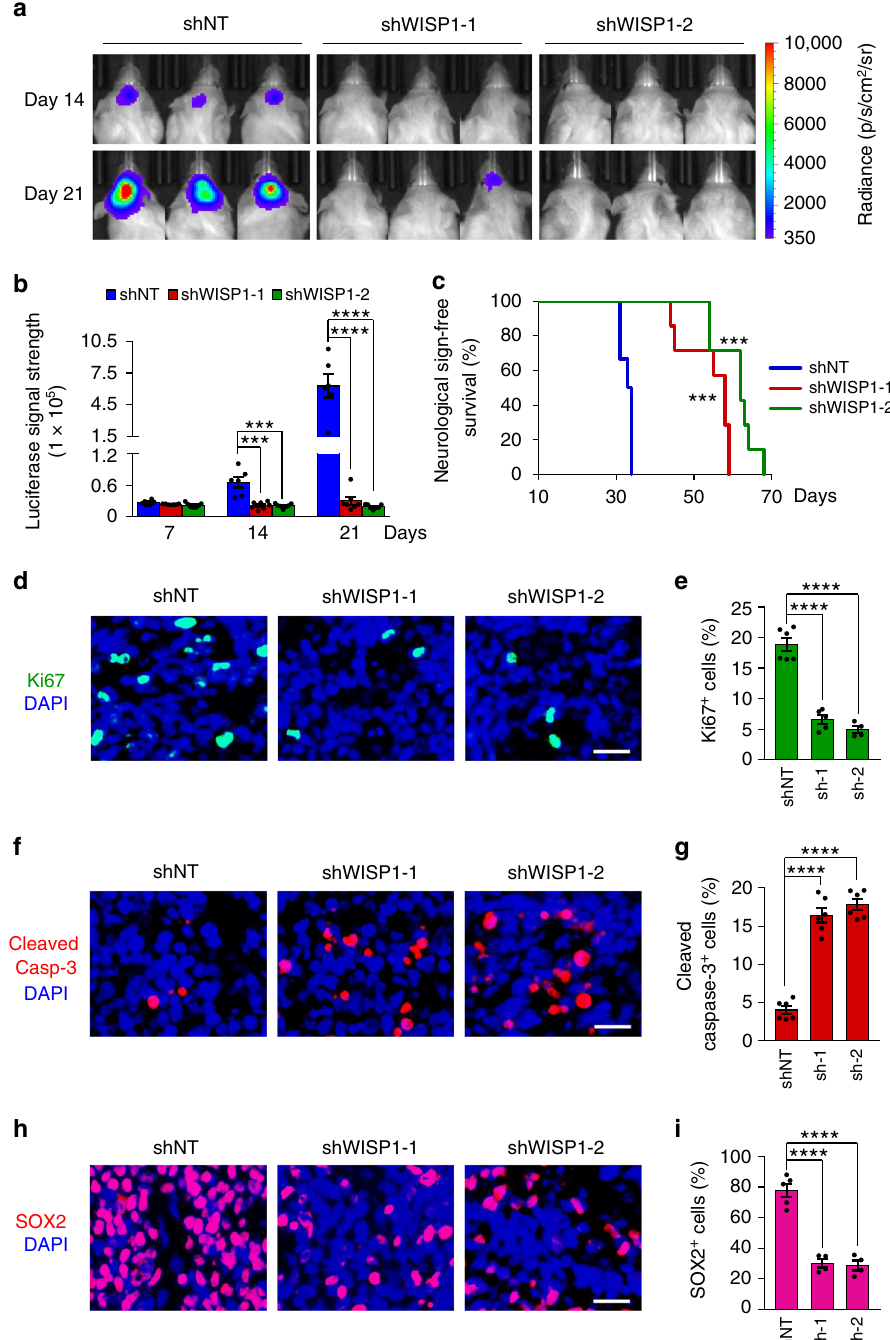
phosphorylation. shRNAs targeting α 6 signi fi cantly decreased Integrin α 6 expression and Akt phosphorylation (pAkt-Ser473) in GSCs (Fig. 5i and Supplementary Fig. 5h). Disruption of Integrin α 6 also signi fi cantly inhibited GSC proliferation and tumorsphere formation (Fig. 5j, k and Supplementary Fig. 5i, j). Taken toge- anti-Integrin α 6 or β 1 antibody. Anti-Integrin α 6 antibody pulled